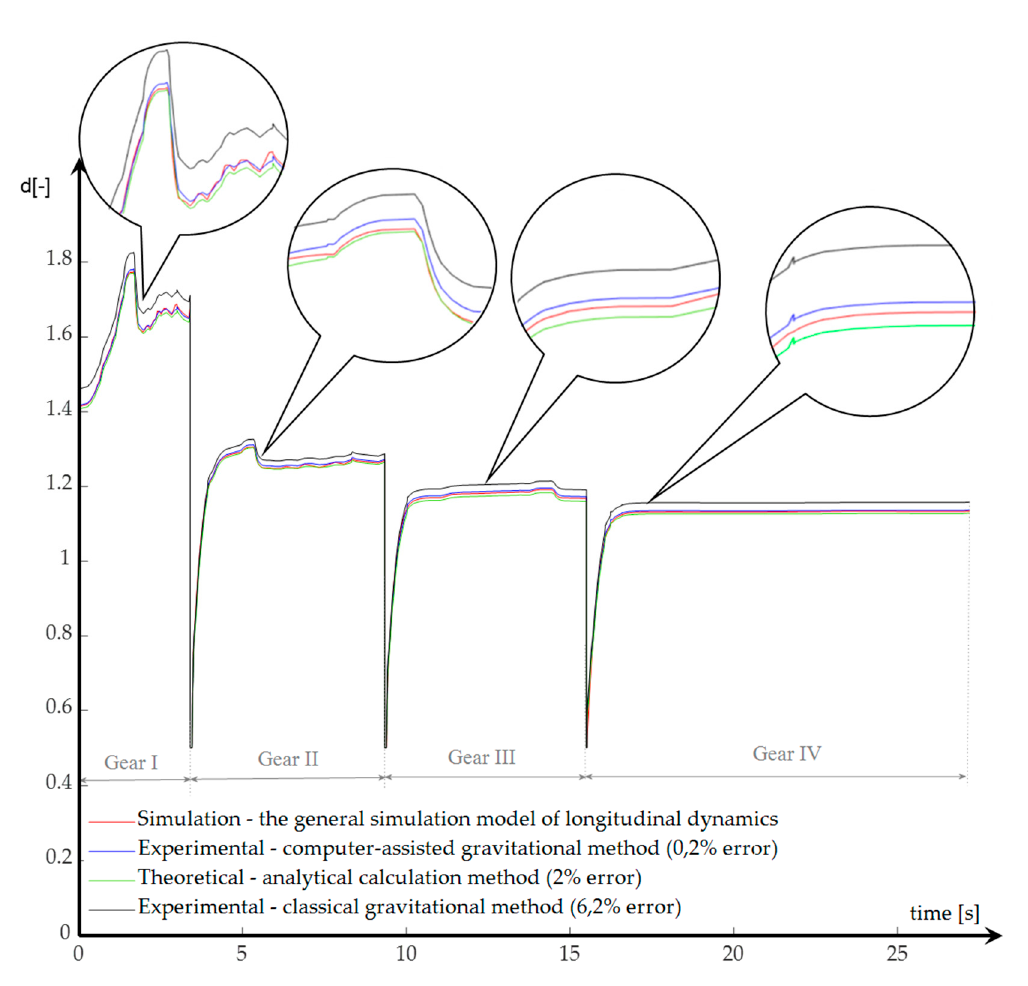
Figure 27. The variation of the coefficient of inertia masses resulting from the experimental data for starting the tracked vehicle.